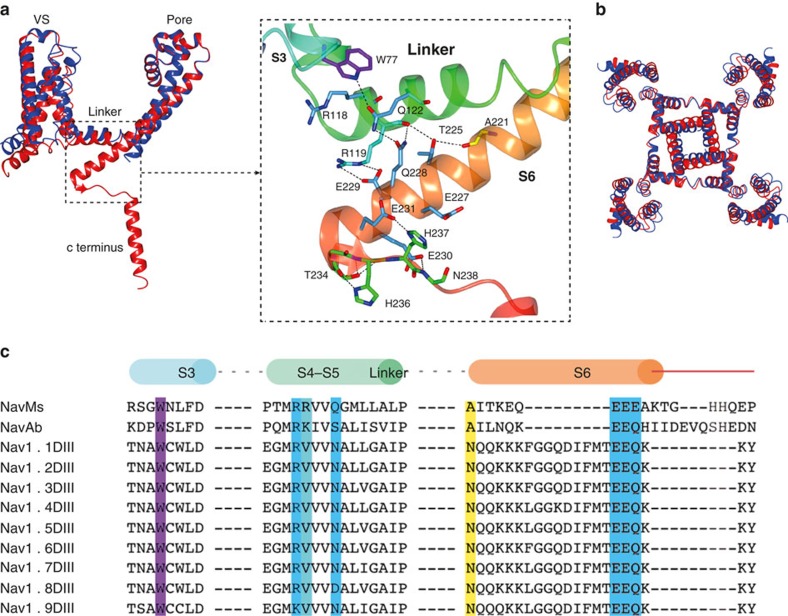
The S4–S5 linker and interaction motif.(a) Overlay of the VS regions of NavMs (red) and NavAb (blue), showing the resulting displacement of the S4–S5 linkers that leads to changes in the juxtapositions of the S5 and S6 helices, producing a wider (open) pore gate in NavMs. The expanded view is of the interaction motif: the region of S3 where W77 is located (ribbon motif, in cyan), the S4–S5 linker (in green), the end of the S6 helix (in orange), and the residues at the top of the NavMs CTD (in blood orange). The colour coding is the same as in the cylinders at the top of c. The residues that form ion pairs and hydrogen bonds (shown in stick representation) are colour-coded as in the sequence overlays in c. (b) Superposition (as a) of the NavMs (red) and NavAb (blue) tetramers, viewed from the extracellular surface, showing that the shift in the linker leading to helices S5 and S6 produces a wider pore gate in the NavMs activated open structure. (c) Sequence alignments of S3, S4–S5 linker and S6-CTD regions of NavMs, NavAb and domains III of human Navs, highlighting the interacting residues in NavMs and the corresponding residues present in the orthologues. They are colour-coded (overlaid) as follows: the conserved Trp in S3 (purple), the residue that forms the hydrogen bond involving polypeptide backbone (yellow), the residues involving side chains (blue), and those involving both types of interactions (cyan). The cylinders at the top are colour-coded as in a (right) to indicate where these residues are in the NavMs structure.